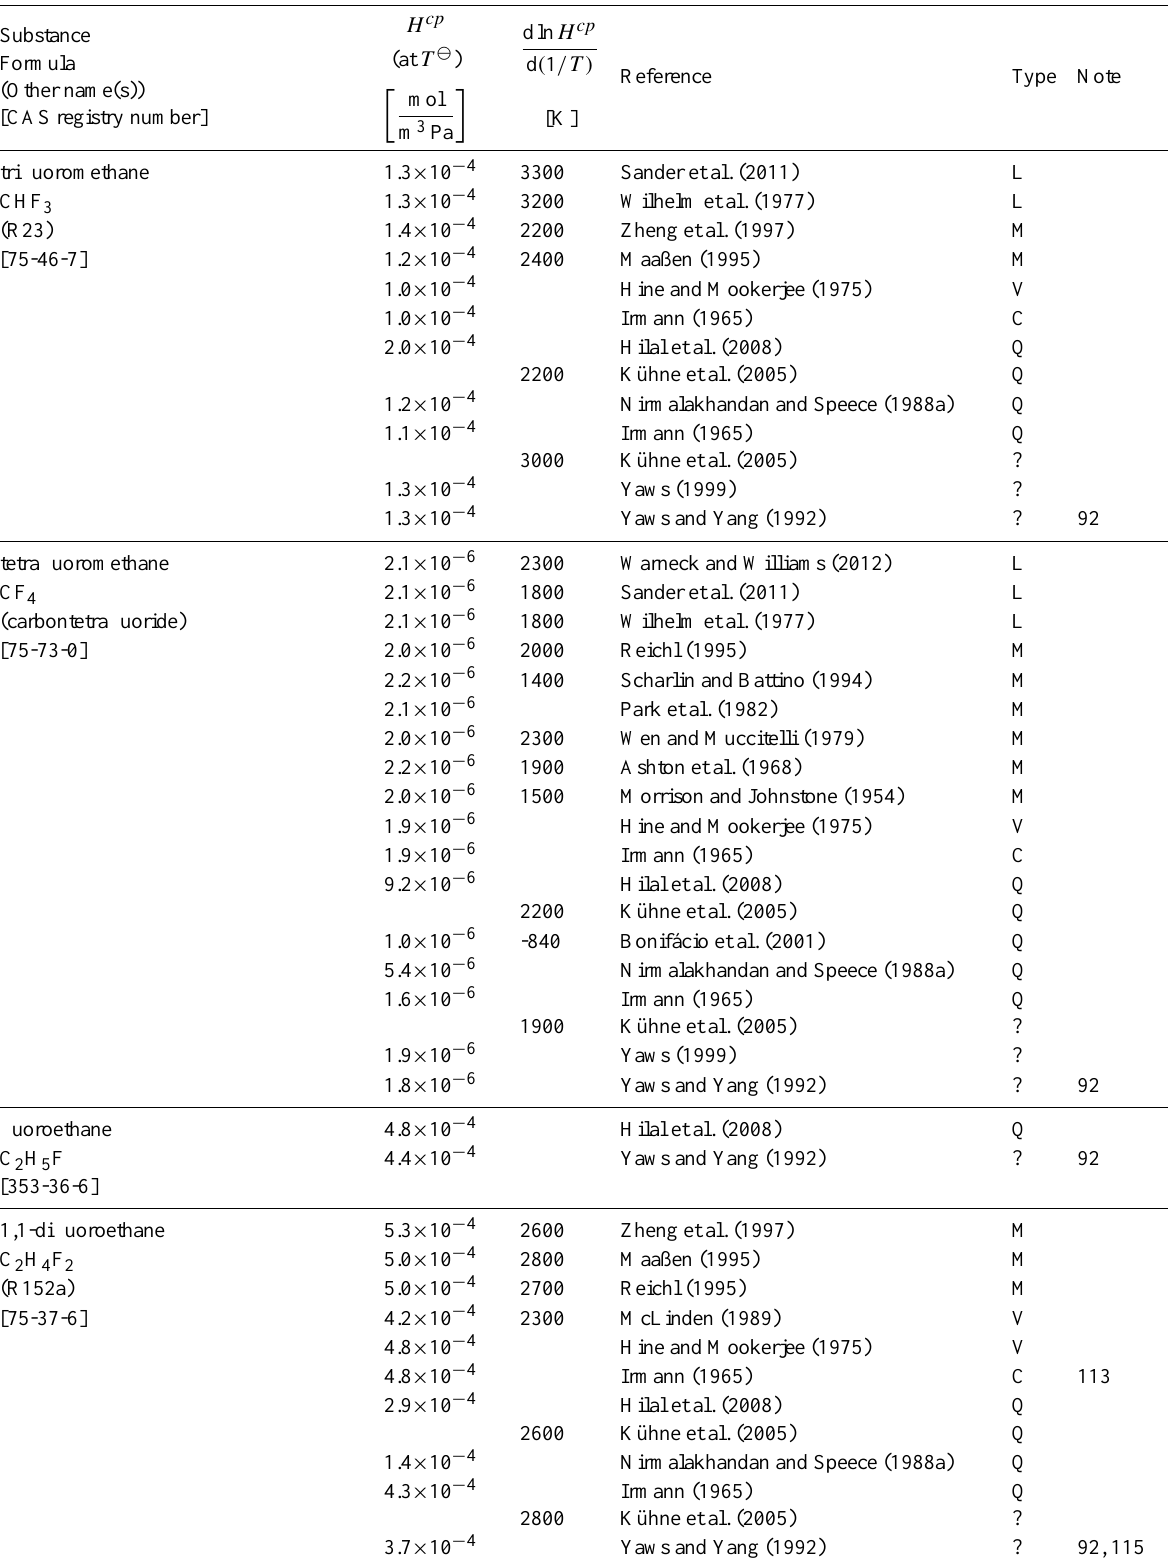
Table 6: Henry’s law constants for water as solvent